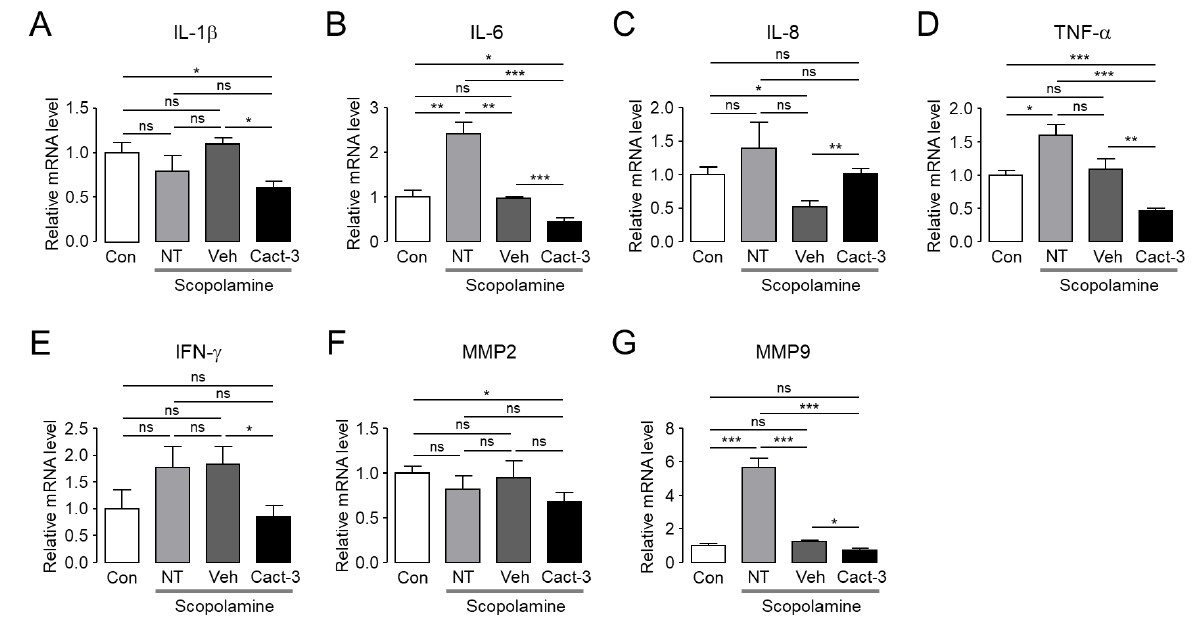
Figure 6. Cact-3 reduced expression of proinflammatory cytokines of cornea and conjunctiva in a scopolamine-induced dry eye mouse model. The relative mRNA expression level of IL-1 β ( A ), IL-6 ( B ), IL-8 ( C ), TNF- α ( D ), IFN- γ ( E ), MMP-2 ( F ), and MMP-9 ( G ) in cornea and conjunctiva were presented. Dry eye mice were treated with vehicle or Cact-3 for 10 days whilst maintaining the dry eye condition (mean ± S.E., n = 4). NT: not treated; ns: not significant. * p < 0.05; ** p < 0.01; *** p < 0.001.